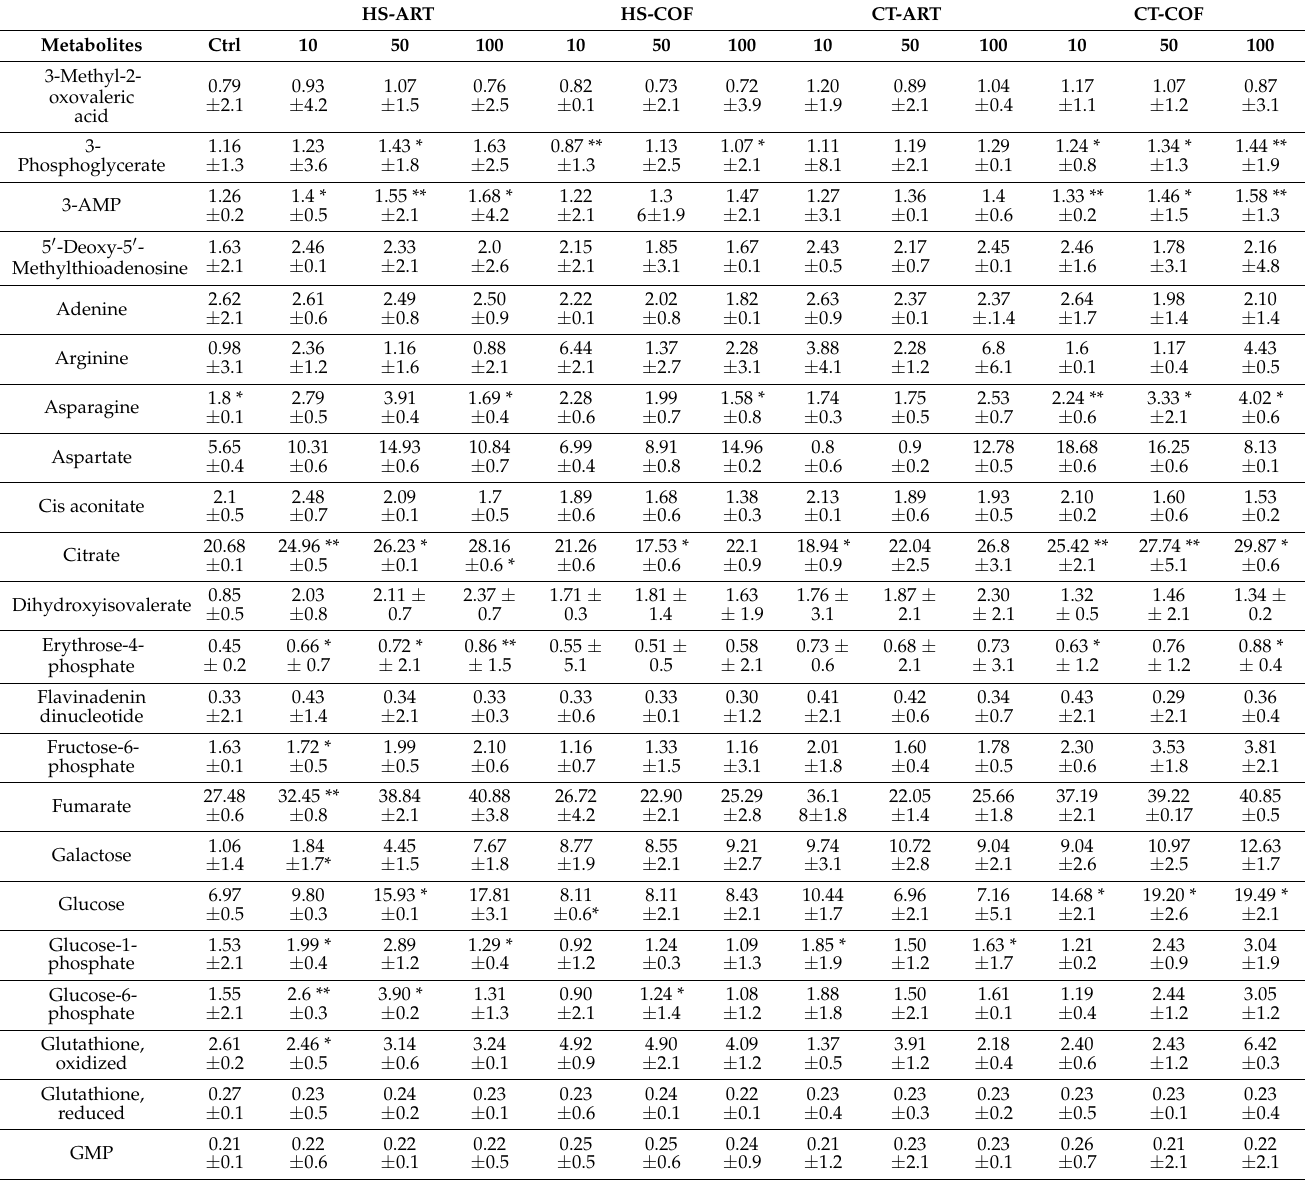
Table 4. Concentration (nmol g − 1 ) of primary and secondary metabolites from basil leaves treated with HS-ART, HS-COF, CT-ART, and CT-COF at different doses (mg L − 1 ) quantified using Skyline software. Asterisks indicate significant differences (* p < 0.05; ** p < 0.01) by two-way analysis of variance (ANOVA). The metabolites reported in bold showed significant differences between plant CTRL and treatment with HS-ART and CT-COF. HS-ART HS-COF CT-ART